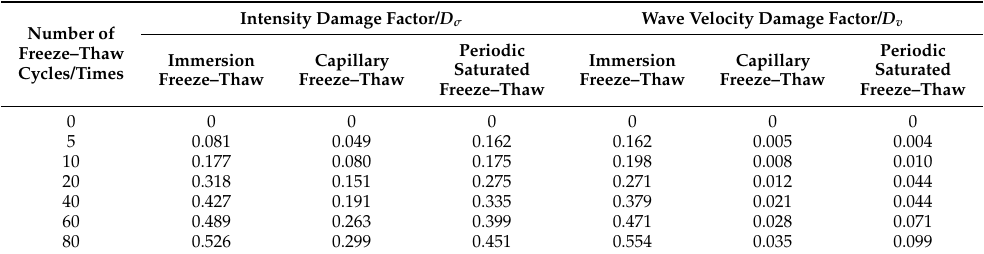
Table 3. Rock damage factors under different freeze–thaw modes.